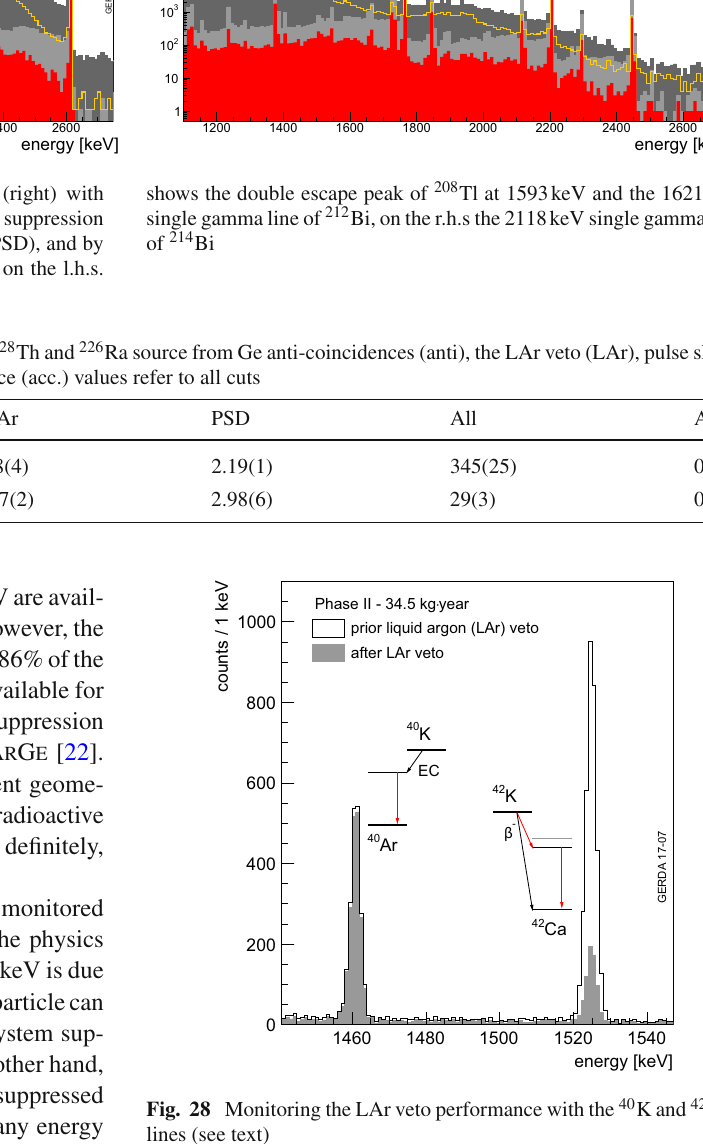
trigger requirements are requested: either 5 Cherenkov PMTs within60nswithasignalabovethresholdof0.5PE,oratriple coincidence within the plastic veto. A mean stability of 4% can be observed. No readjustment of the HV was necessary during the 477 days of operation of Phase II. The mean daily rate of 3164(6) muons was measured which translates into a rate of 3 . 54 × 10 − 4 /( m 2 s ) . This is a 1.8% deviation from the mean of Phase I [42], still consistent and giving hints on systematic